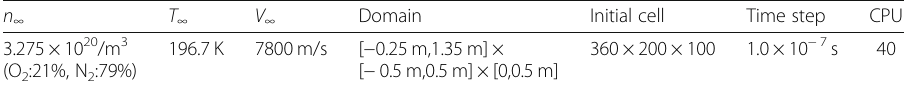
Table 3 Computational parameters for the case of RAM-C II at 81 km n